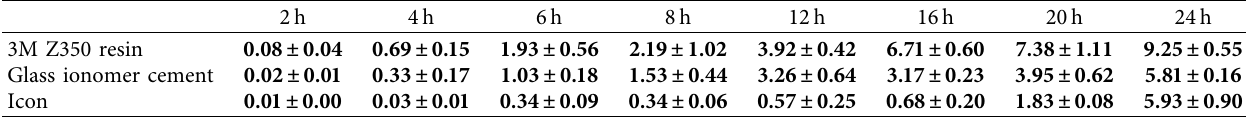
Table 5: Actinomyces viscosus group (plate colony counting).